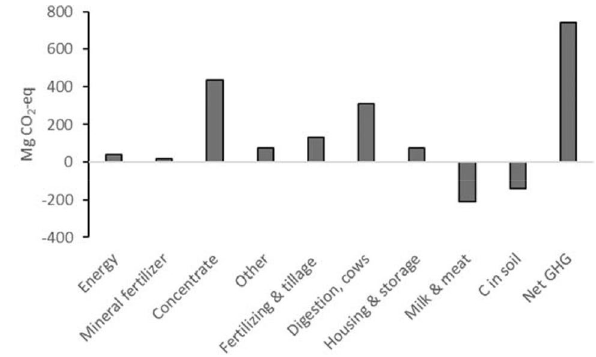
Fig. 4 Greenhouse gas (GHG) emissions from the dairy farm, calcu- lated using carbon capture-life cycle assessment